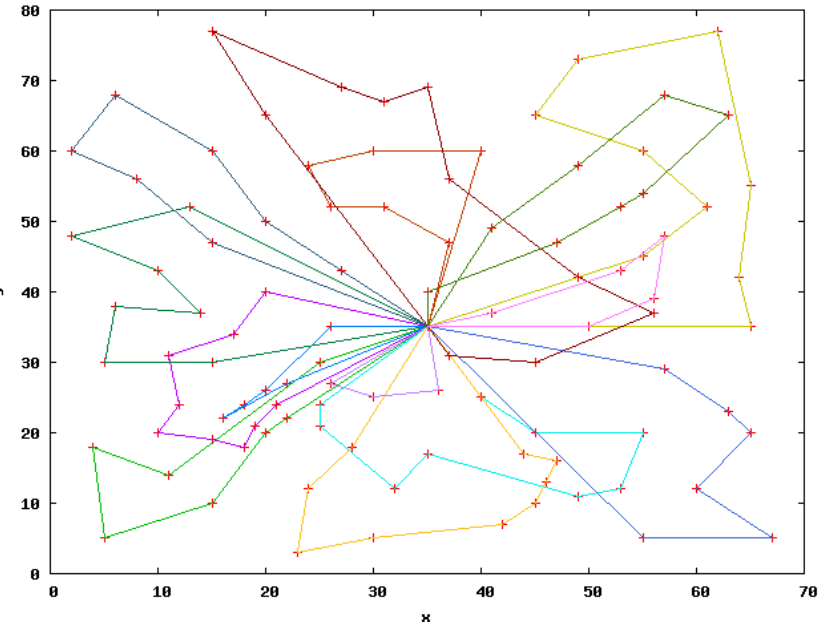
Figure 20. Best combinations, long, large examples experiment–example for largest Christophides and Eilon set E, with fitness distance from the best known one around